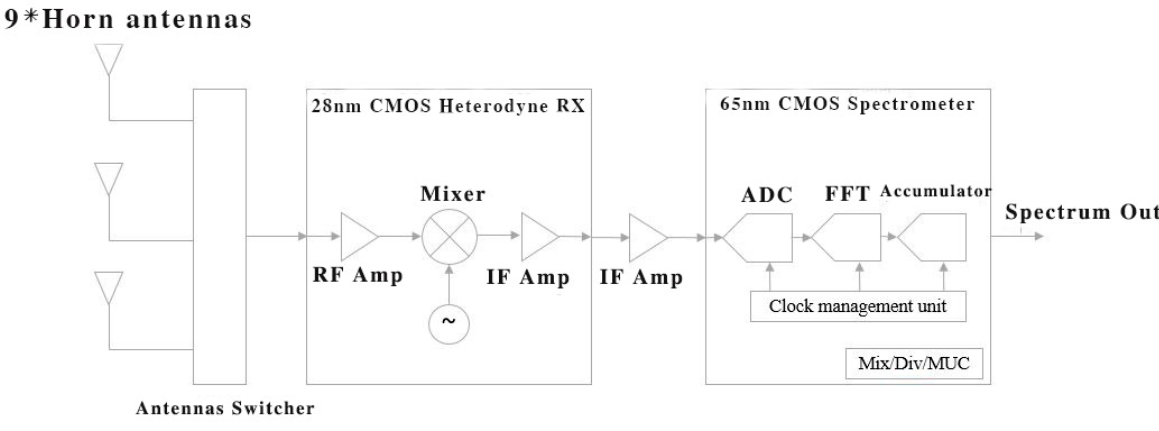
Figure 3. THz Heterodyne-Spectrometer block diagram.